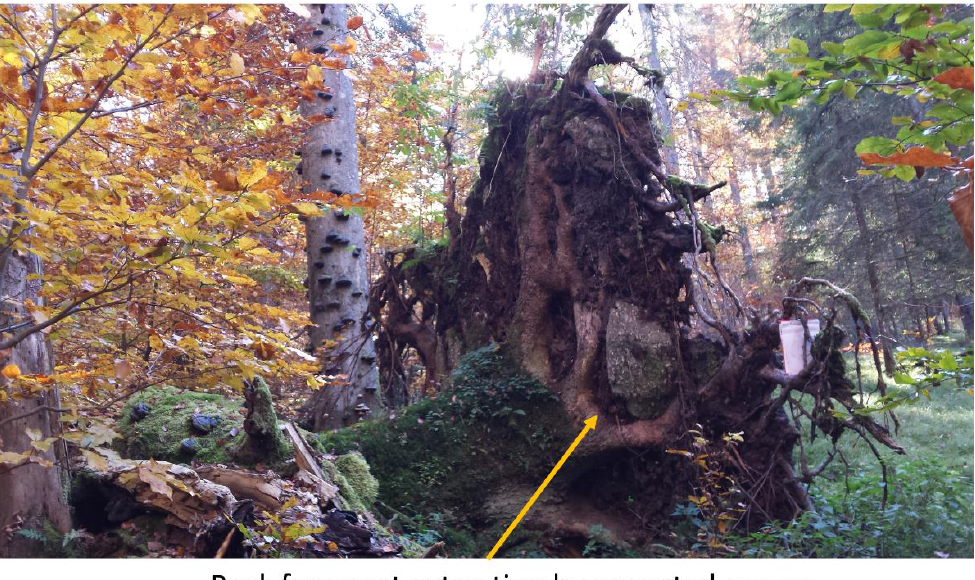
Figure 4. Rock fragment extraction by an uprooted spruce. On the right is a notebook to compare the size of the roots and rock.